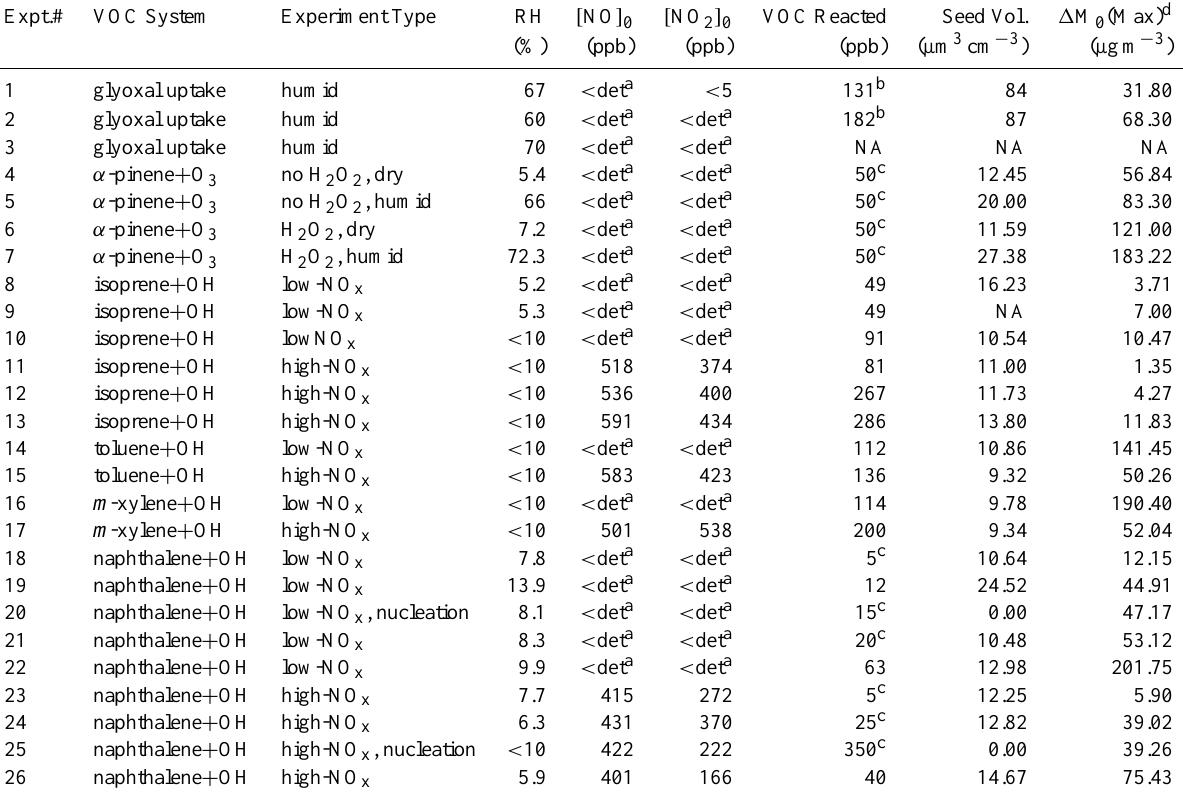
Table 1. Experimental conditions and results.